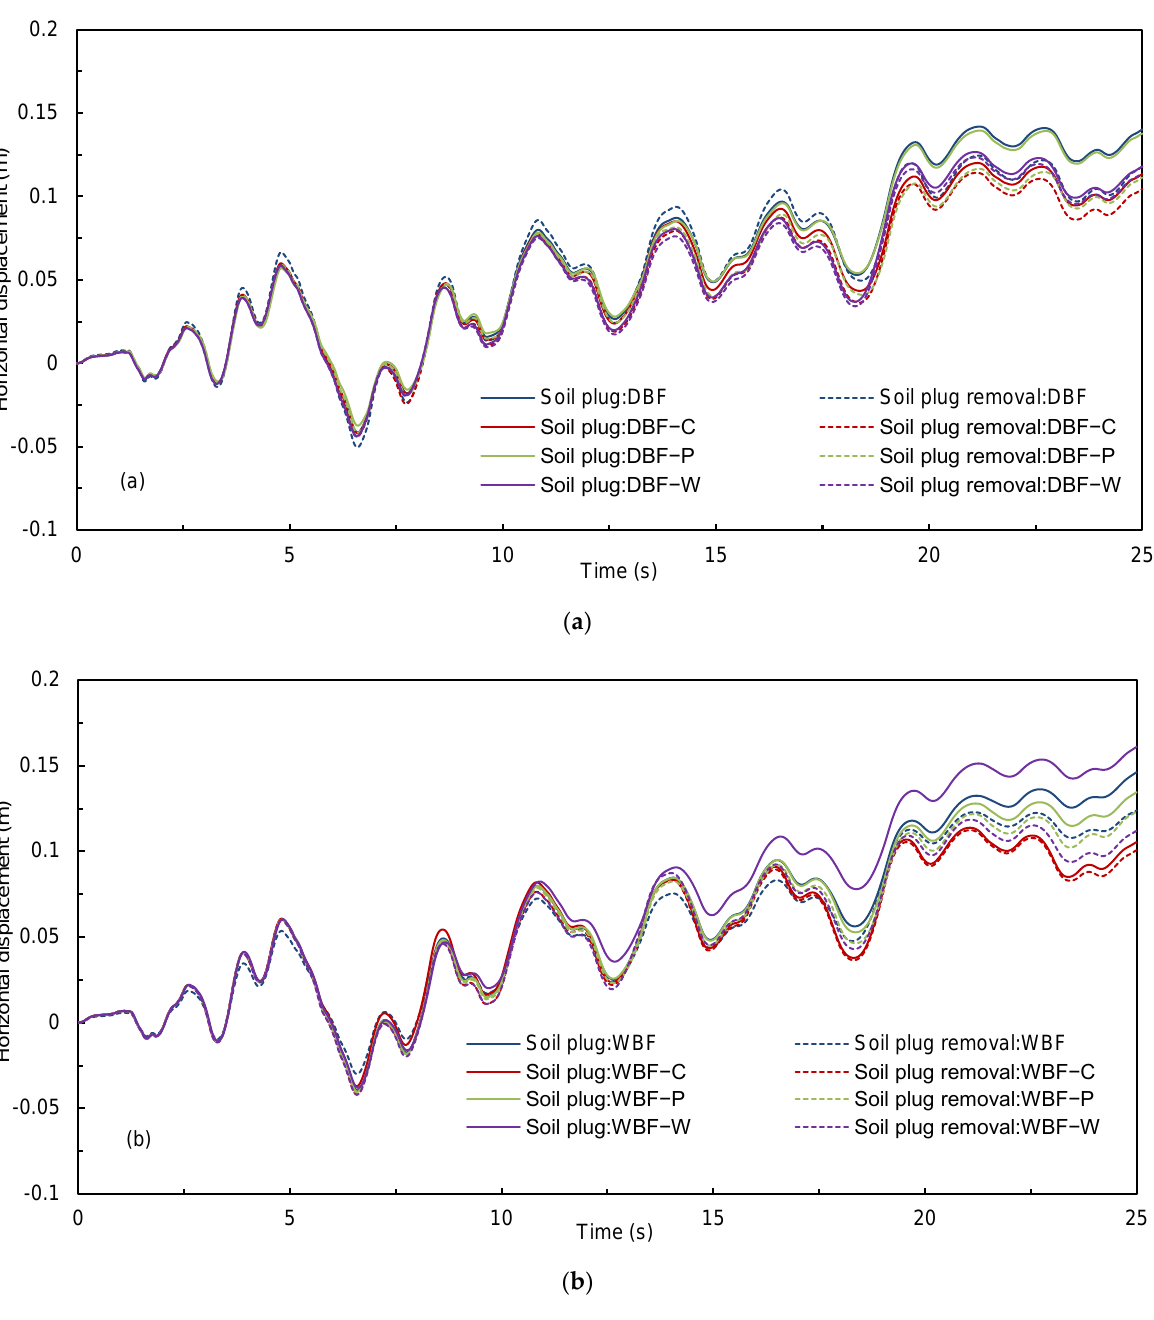
Figure 19. The horizontal displacement time histories of unreinforced and reinforced bucket foundations for simulations with soil plug and soil plug removal in 50% relative density inclined seabeds: (a) deep bucket foundation (DBF); (b) wide bucket foundation (WBF). In terms of bucket rotation, the removal of soil plug also had a favorable effect (Figure 20). For the deep bucket foundation, the stability of the bucket foundation was slightly improved for the unreinforced and all types of reinforced cases (Figure 20a). For the wide bucket foundation, soil plug removal was shown to massively reduce the rotation of the bucket without reinforcement (Figure 20b). When combined with reinforcement, rotation was further limited by plug removal. Specifically, the rotation of the bucket was brought within the failure rotation criterion of 0.25 ° when soil plug removal was combined with inner compartment reinforcement (WBF-C).